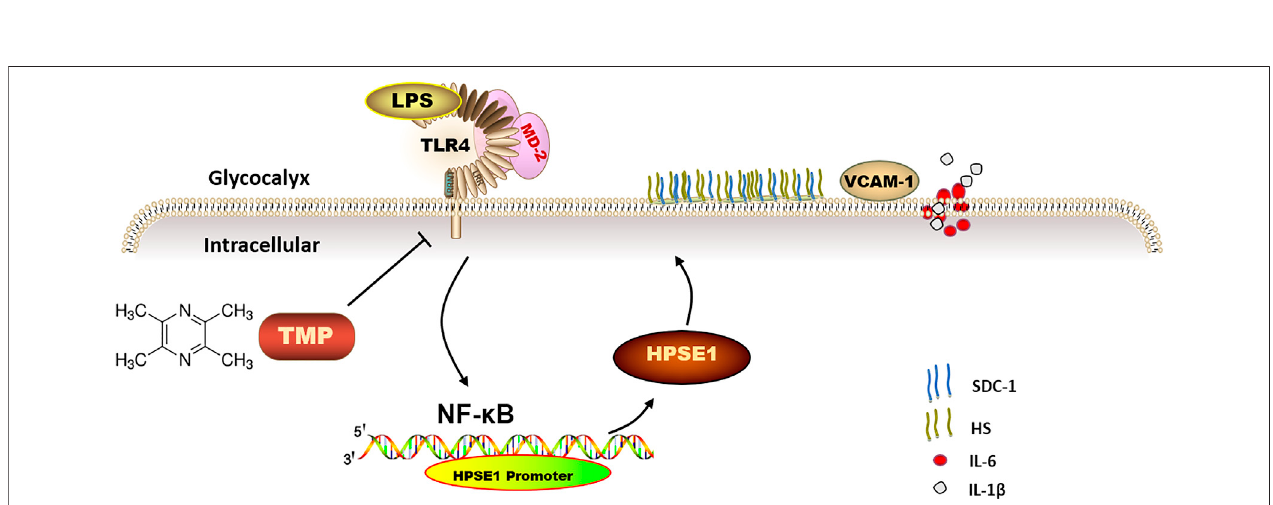
FIGURE8| ThemechanismofTMPprotectingendothelial glycocalyxand maintainingendothelialfunction.TMPcaninhibittheexpressionofglycocalyxdegrading enzymes by inhibiting TLR4 to inhibit HPSE1 or directly inhibit HPSE1, and protect the integrity of glycocalyx structure.